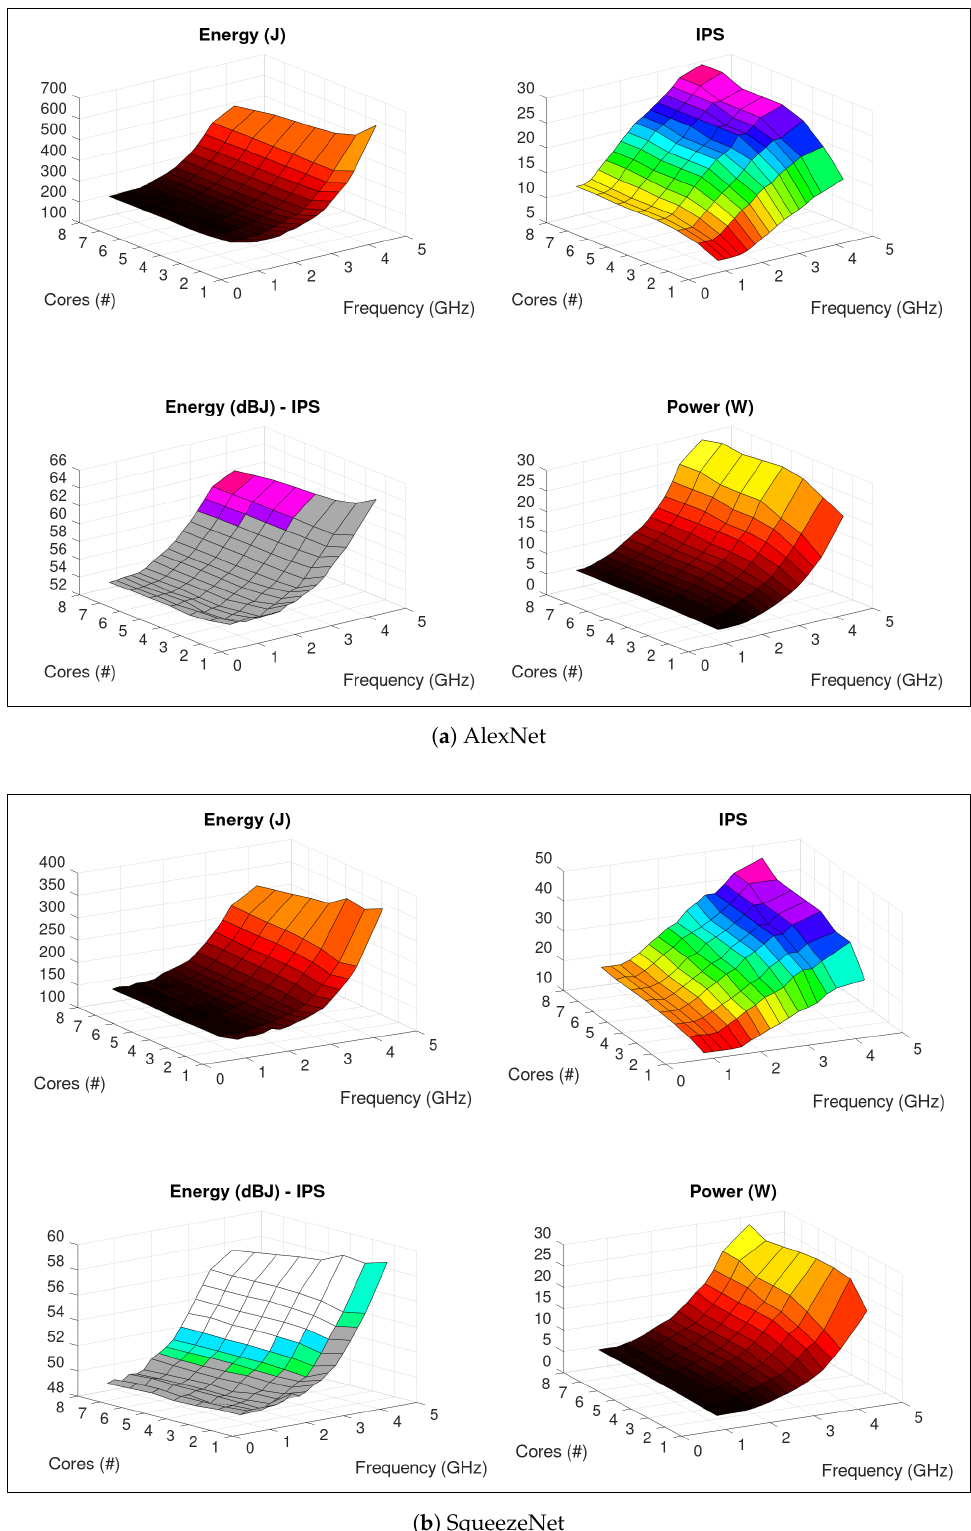
Figure 6. ML image inference—profiling on a Intel Core i7-7700 system. On Energy and Power, lighter colors represent higher values. IPS colors are defined in HSV scale, corresponding to application performance levels. On Energy—IPS chart, gray represents settings with application performance below defined threshold; white regions group system configurations that exceed QoS levels; HSV colors reflect out same application performance levels as